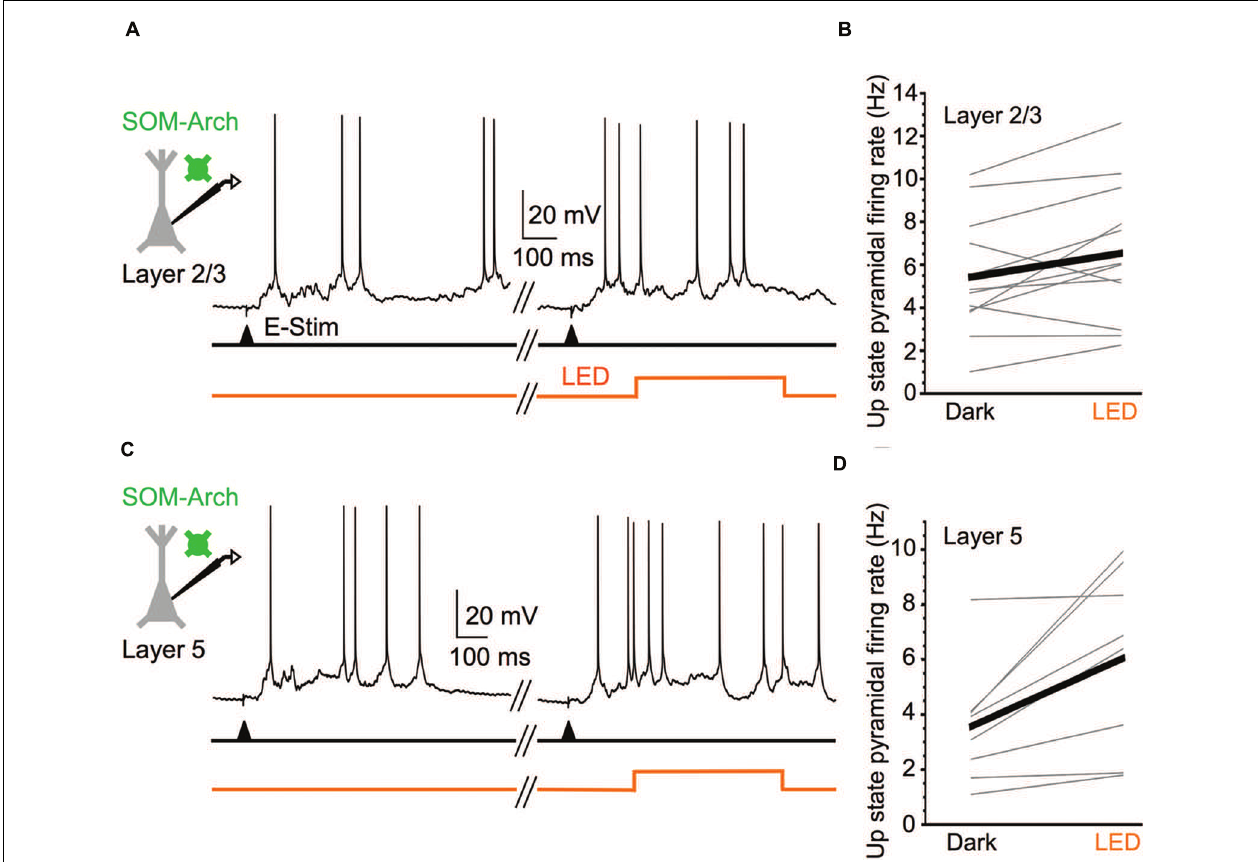
FIGURE 2 | Silencing SOM cells during Up states increases pyramidal cell excitability. (A) Representative Up state membrane potential trace of a layer 2/3 pyramidal cell with and without optogenetic stimulation of Arch-expressing SOM cells in layer 2/3. (B) Population data demonstrating layer 2/3 pyramidal cell Up state firing rates increase when SOM cells are silenced ( n = 12 cells; Dark: 5.4 ± 0.8 Hz, LED: 6.5 ± 0.9 Hz, P = 0.037, paired t -test). (C) As in (A) , but for a representative layer 5 pyramidal cell. (D) As in (B) , but for layer 5 pyramidal cells ( n = 8 cells; Dark: 3.6 ± 0.8 Hz, LED: 6.0 ± 1.2 Hz, P = 0.018, paired t -test).